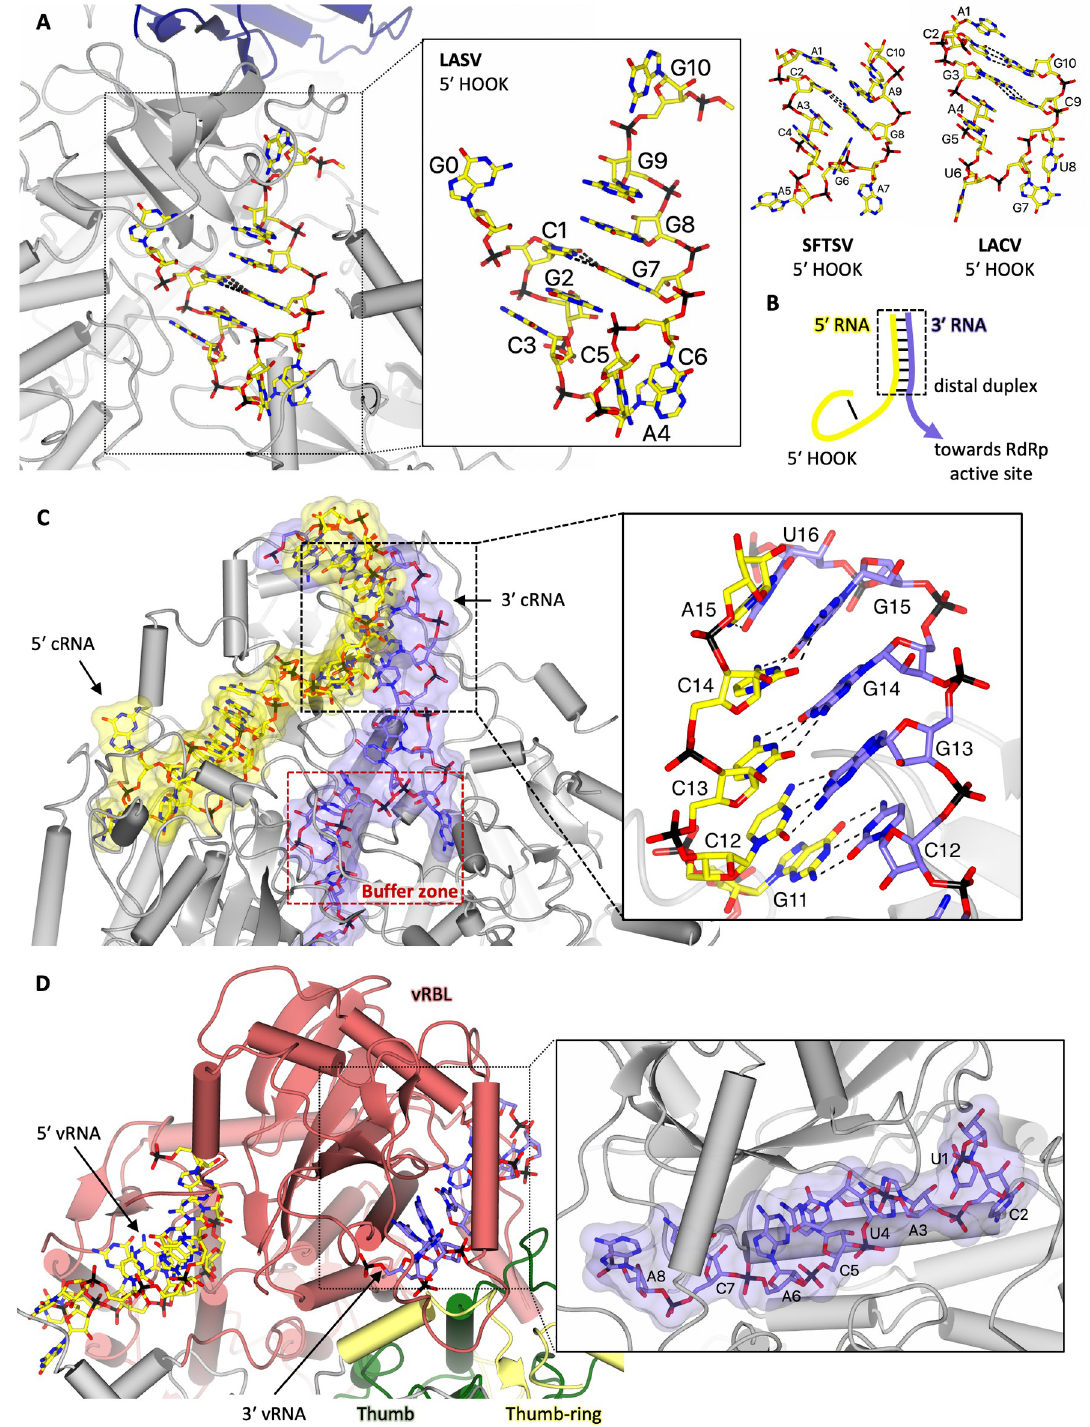
Fig 3. Insights into 5 0 RNA hook coordination, distal duplex conformation, and 3 0 template RNA sequestration. (A) A top-down view of the 5 0 vRNA hook binding site in the LASV L protein (PDB: 7OJN) [48] is shown. The L protein core is shown in grey, whereas the pyramid domain is shown in dark blue with the 5 0 vRNA coloured yellow. Interactions between cognate base pairs are represented by dashed lines. A close-up on the LASV 5 0 vRNA hook is shown with individual nucleotides labelled accordingly. For comparison, the 5 0 RNA hook motifs of SFTSV (PDB: 8ASB) [50] and LACV (PDB: 7ORN) [49] are also shown. (B) A schematic depiction of the promoter structure at pre-initiation with the 5 0 RNA in yellow, the 3 0 RNA in purple, and the distal duplex region as well as the 5 0 hook